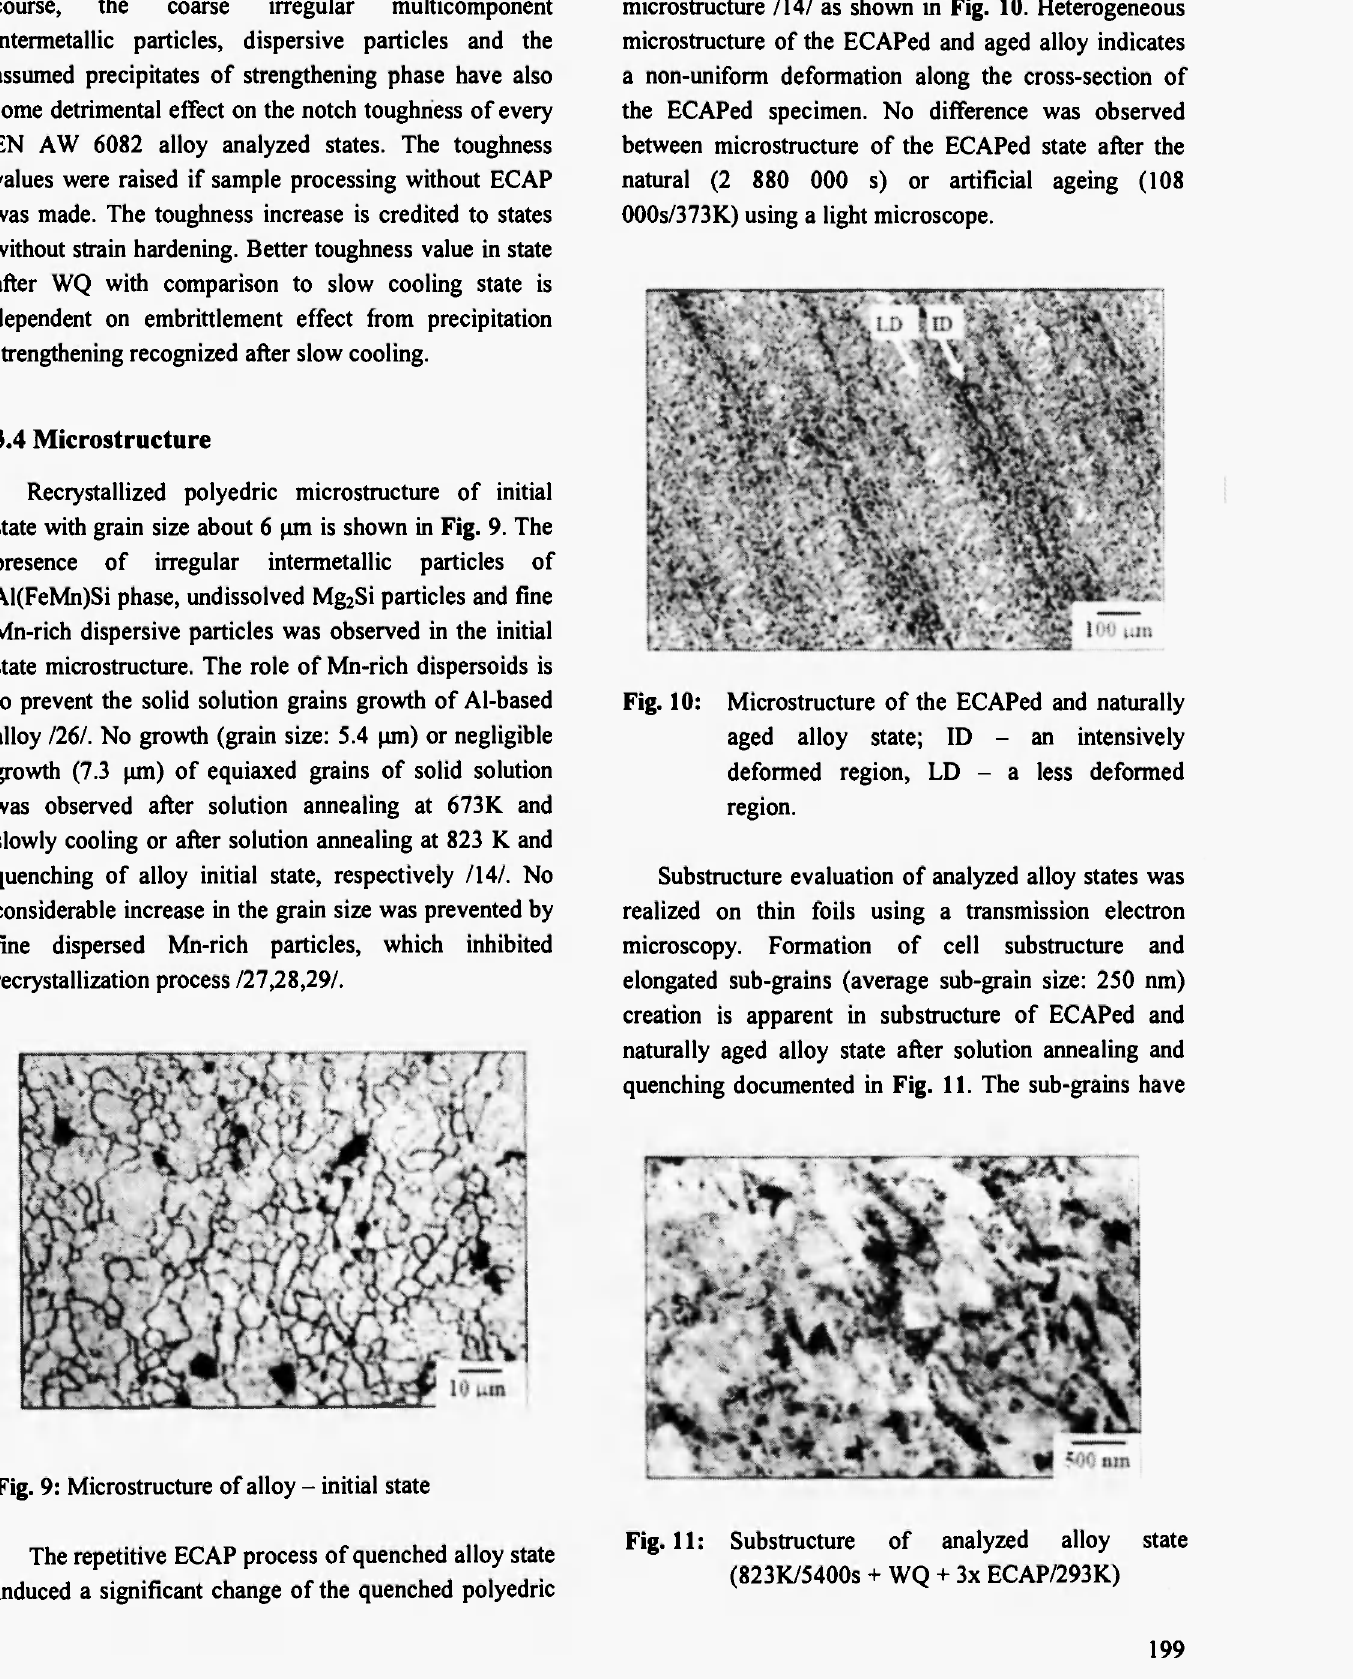
Fig. 11: Substructure of analyzed alloy